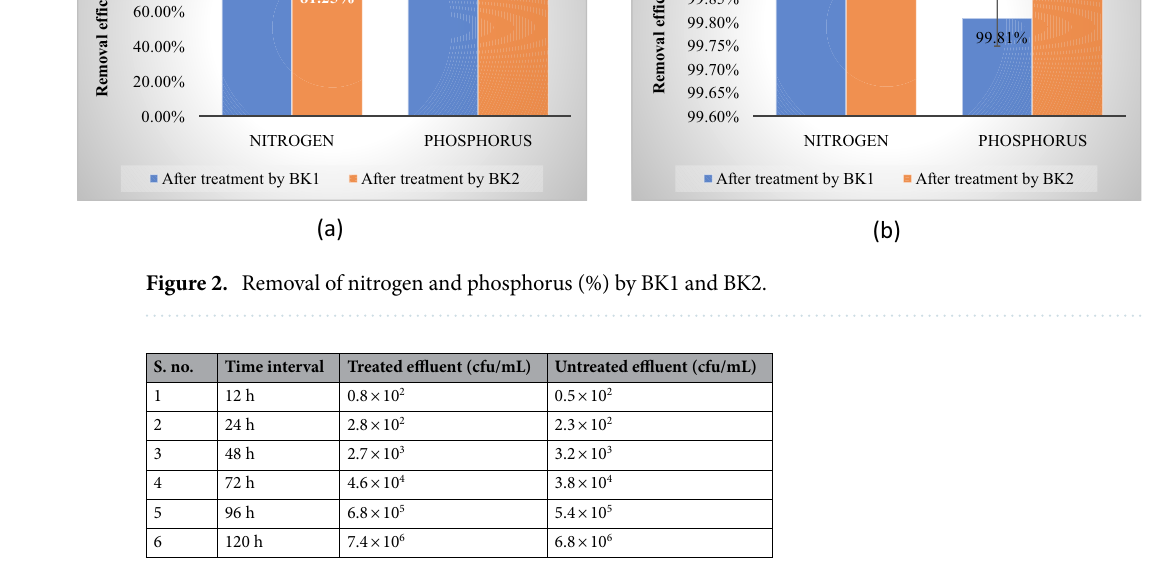
Table 5. Colony forming unit observed in (cfu/mL) at different time intervals.